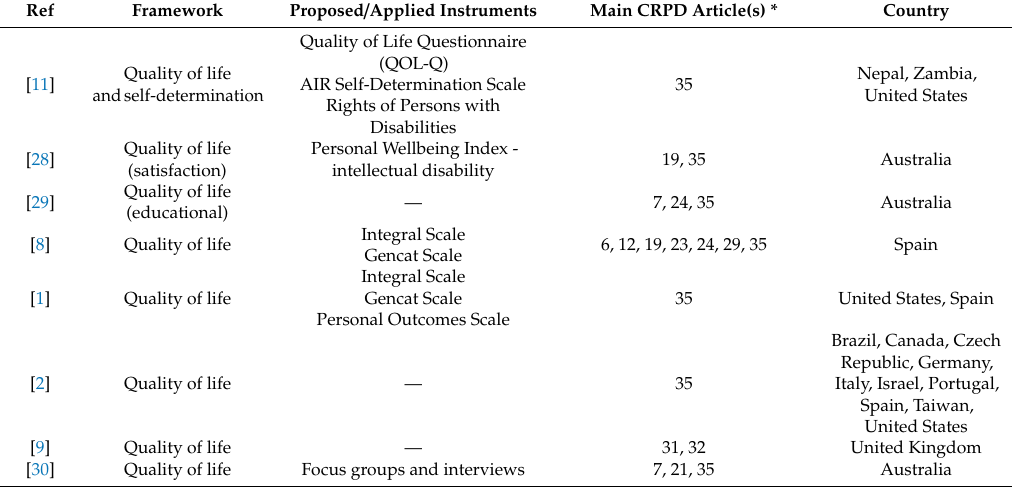
Table 3. Proposed theoretical frameworks for CRPD